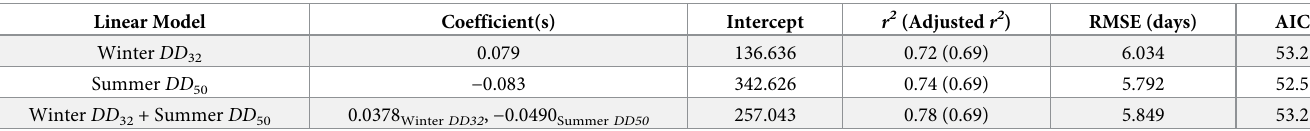
Table 2. Linear model fit parameters of Drosophila suzukii first capture